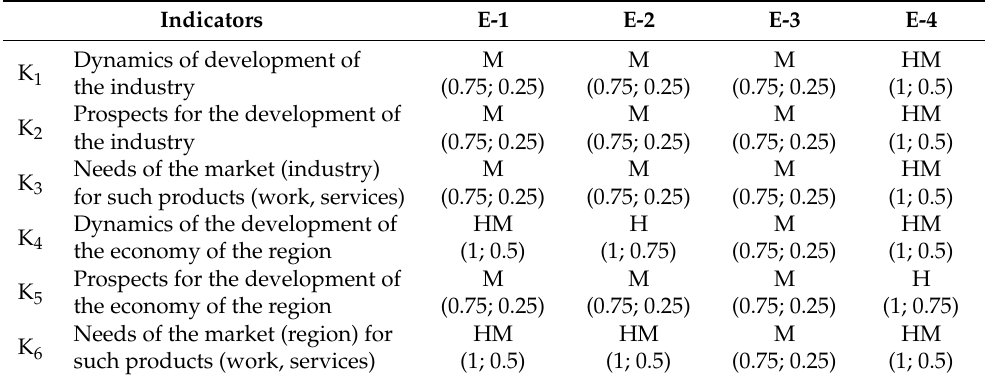
Table 3. Input variables—indicators of industry and regional specifics.